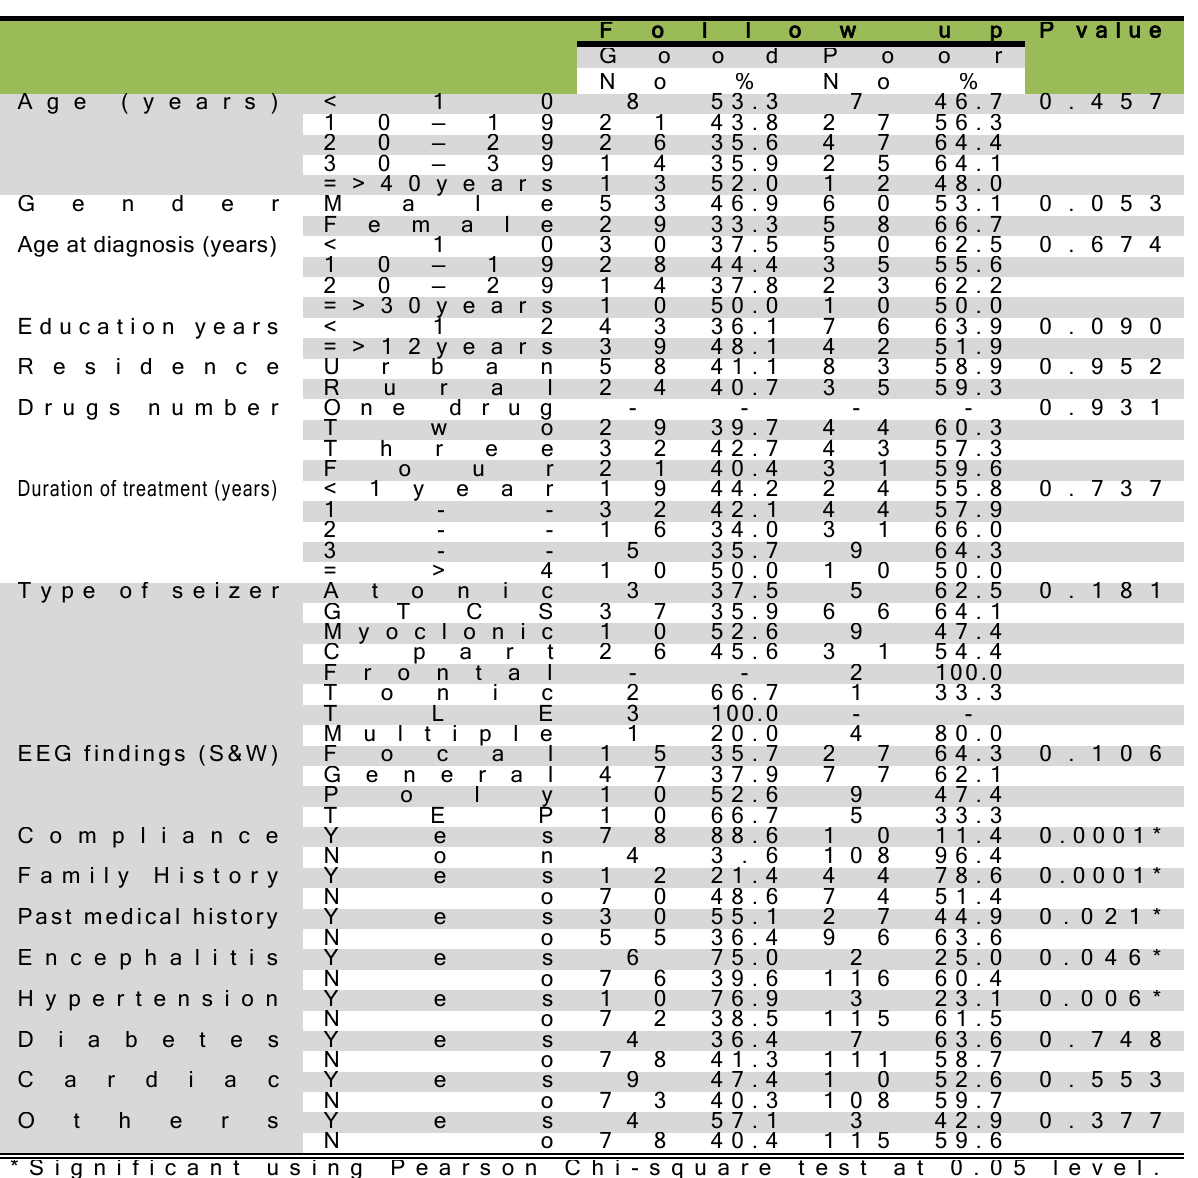
Table 9: Statistical association of follow-up with patients'